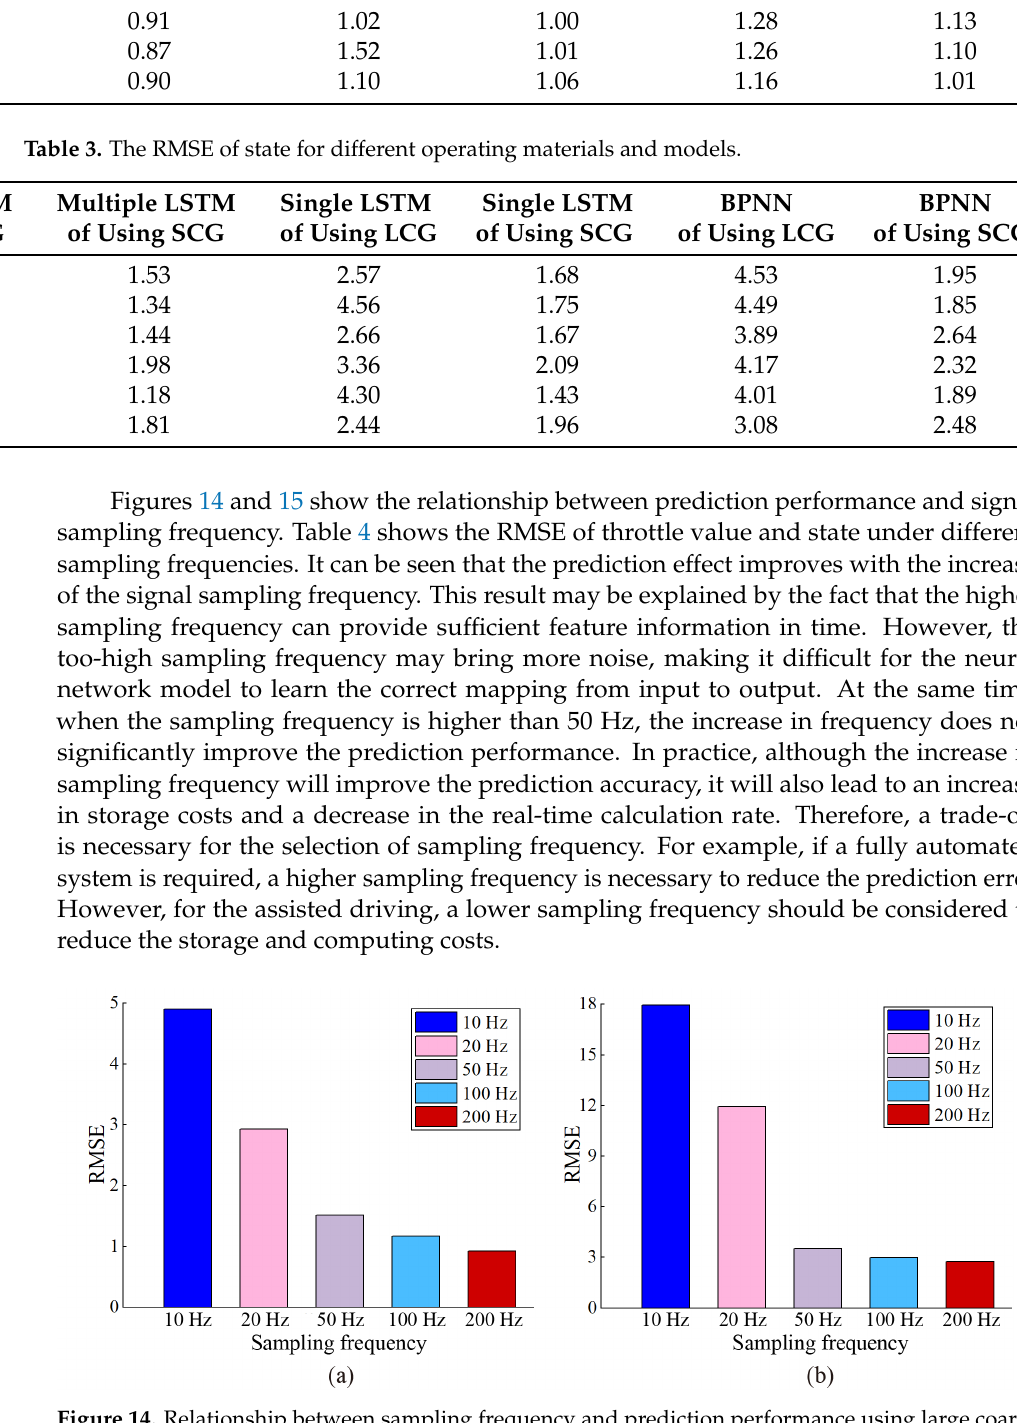
Figure 14. Relationship between sampling frequency and prediction performance using large coarse gravel: ( a ) prediction of throttle value ( b ) prediction of